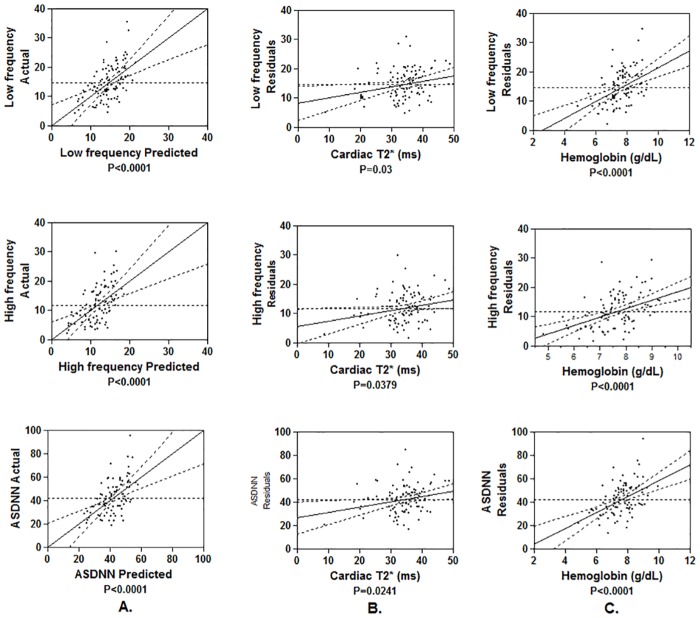
The scatter plots for the correlation between HRV [1) low frequency (upper row), 2) high frequency (middle row) and 3) ASDNN (lower row)] and hemoglobin and cardiac T2*.A: whole model of multiple linear regression analysis; B: the correlation between HRV and cardiac T2*; C: the correlation between HRV and hemoglobin. ASDNN, the average of the standard deviation of all R-R intervals for all 5-minute segments in the 24-hour recordings.